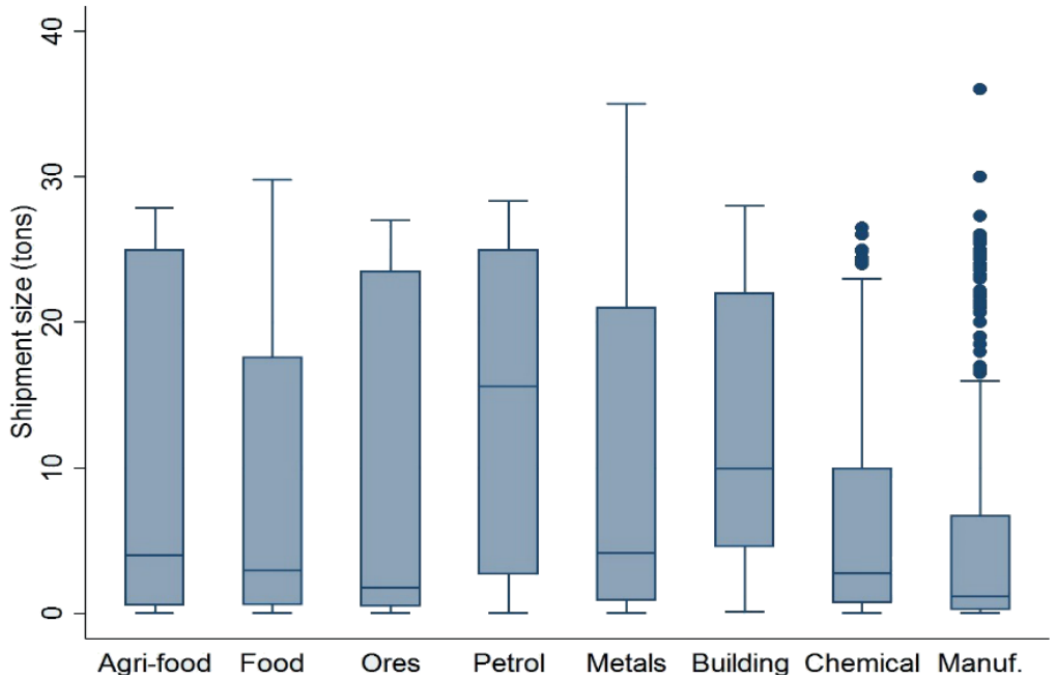
Figure 1: Boxplots of shipment sizes carried by road according to NST/R chapters proposed in the ECHO